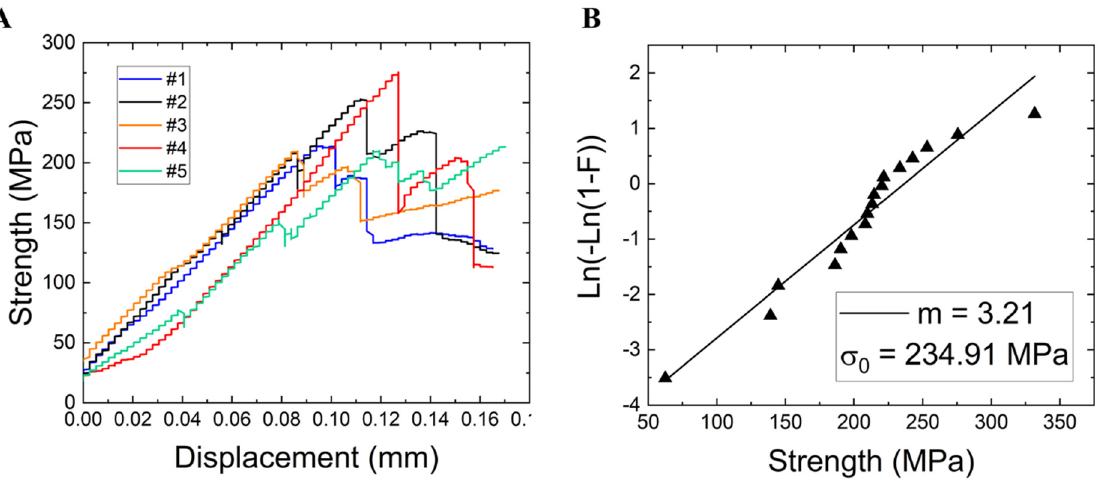
Figure 10. Mechanical data from C/C-SiC composite samples subjected to ( A ) four-point bend tests (stress versus. displacement) and ( B ) Weibull statistics.